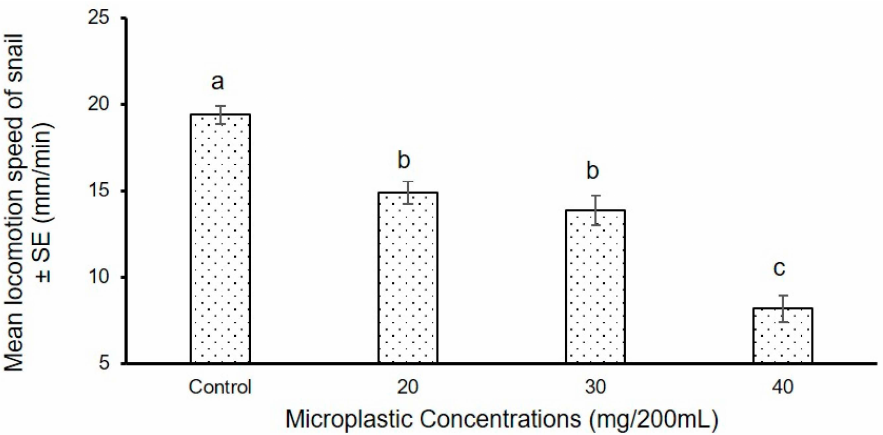
Figure 4. Weighted average of 93 days’ locomotion speed of P. acuta in control (without MPs) and in the medium applied with three concentrations of MPs (20, 30 and 40 mg/200 mL) ( n = 93). Data points with differences superscribed with different alphabets are statistically significant ( p <